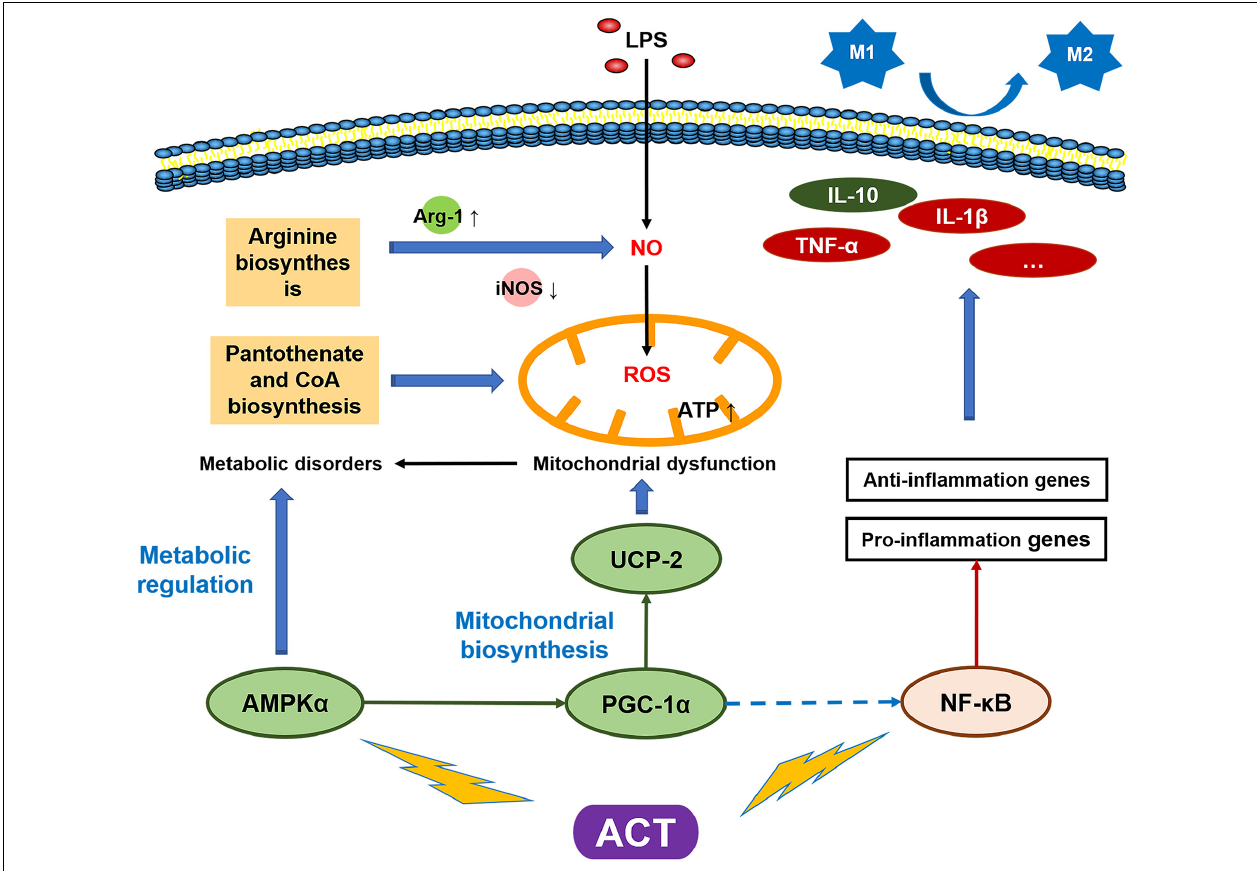
FIGURE 6 | Schematic model of the mechanism by which ACT suppresses LPS-induced M1 polarization via regulating AMPK and NF- κ B signaling